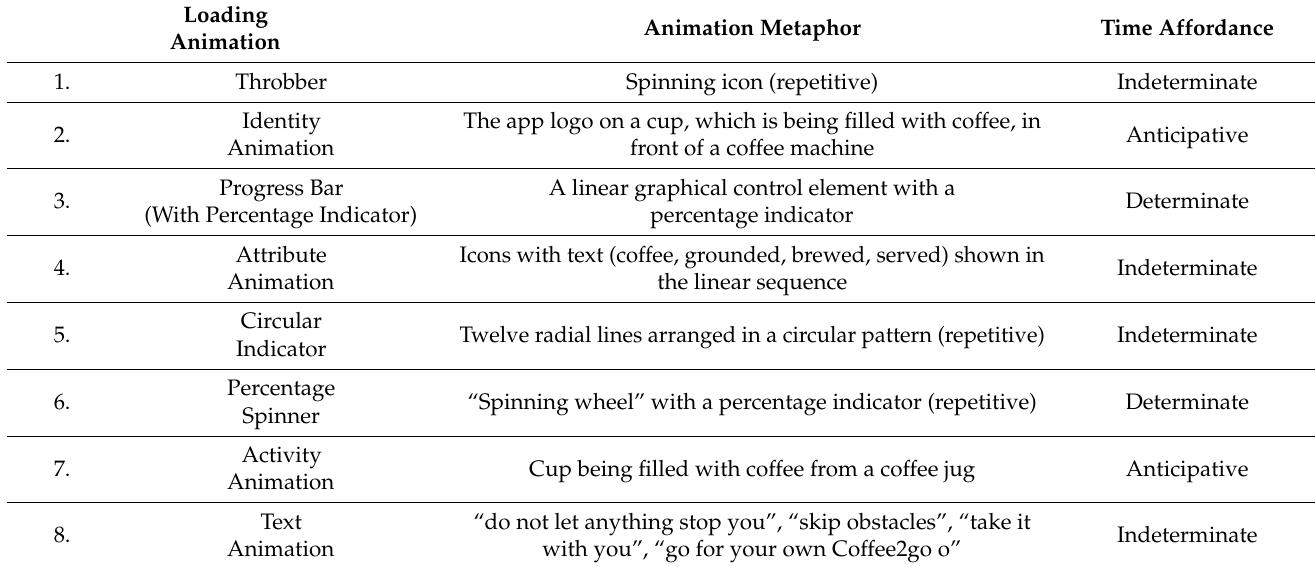
Table 1. Loading-animation type and design